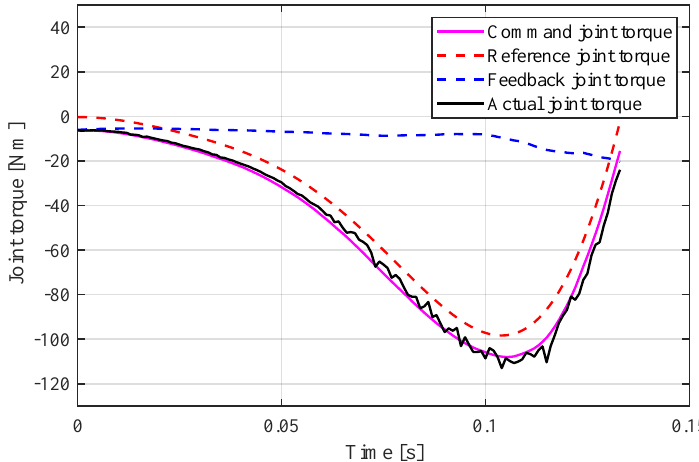
Figure 14. Joint torque of